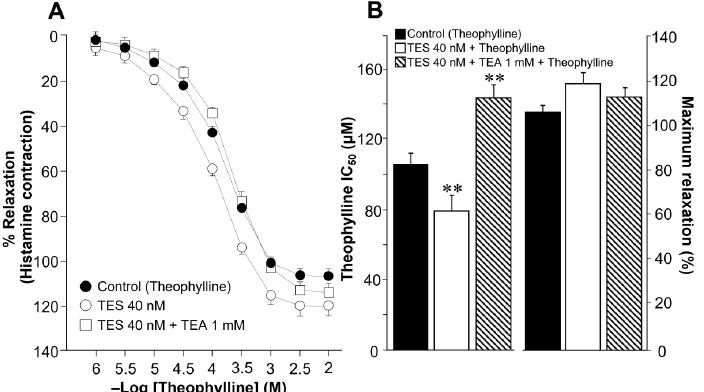
Figure 3. Testosterone (TES) incubated for 48 h enhances theophylline-induced relaxation of guinea pig tracheal rings, whereas tetraethylammonium (TEA) blocks TES potentiation, indicating that K + channels are involved in the androgen effect. ( A ) Cumulative concentration curve of theophylline relaxes tracheal rings precontracted with histamine (10 µ M). Incubation of the tissues with TES 40 nM ( n = 8) for 48 h results in a leftward shift of the concentration-response curve to theophylline. When TEA is applied, the enhancement of the theophylline concentration-response curve caused by TES is abolished. ( B ) Bar graphs show that TES 40 nM significantly decreases the theophylline inhibitory concentration by 50% (IC 50 , right panel) compared with the control group. The addition of TEA 1 mM increases the theophylline IC 50 , suggesting the role of K + channels in the androgen action. The maximal response (left panel) to theophylline was not different between groups. Symbols and bars represent mean ± S. E. M., ** p < 0.01. Repeated-measured analyses of variance were performed, followed by Dunnett’s multiple comparison